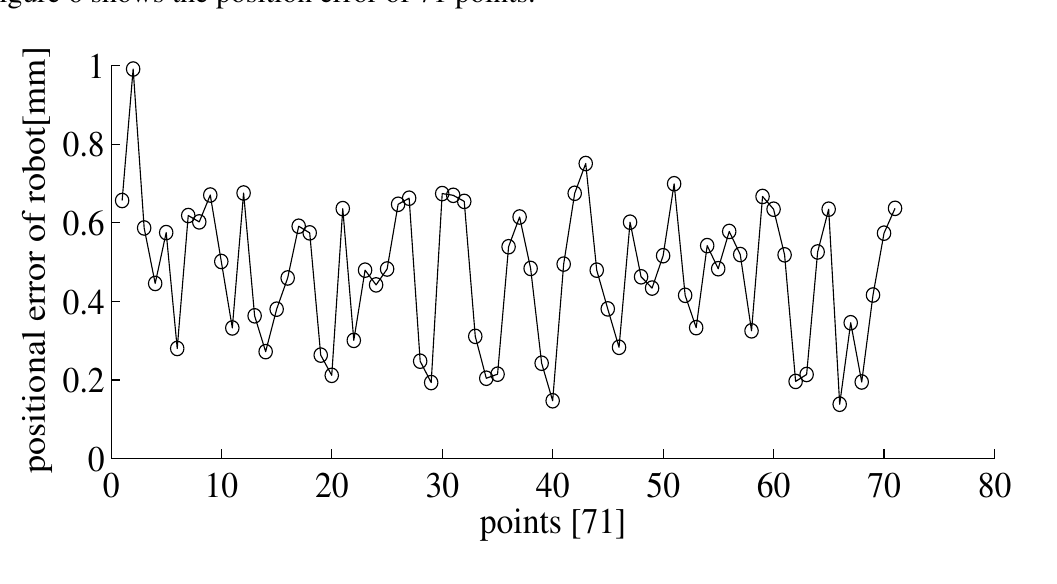
Figure 6. The position error of the robot after